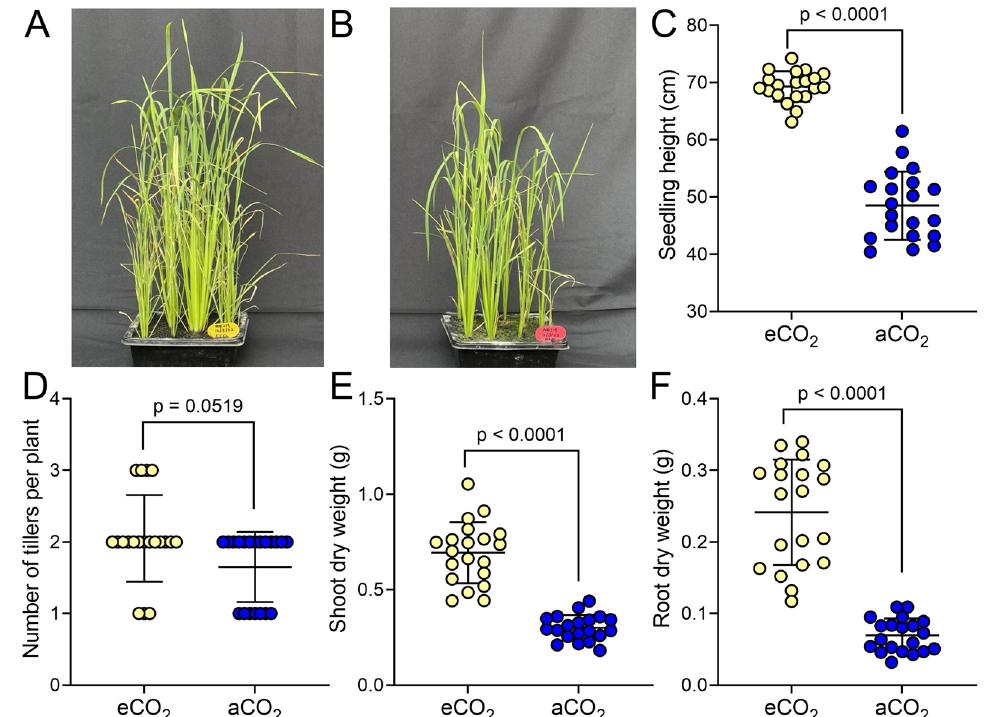
Fig. 4 Rice seedling growth is increased in a mycelium eCO 2 chamber. A , B MR219 seedlings 27 DAS grown at eCO 2 in mycelium controlled chamber ( A ) or at aCO 2 ( B ). C – F For seedlings harvested at 28 DAS, seedling height ( C ); number of tillers ( D ); shoot dry weight ( E ) and root dry weight ( F ) is higher in eCO 2 grown seedlings. C , E Unpaired t test with Welch’s correction, n n 20. p values as =